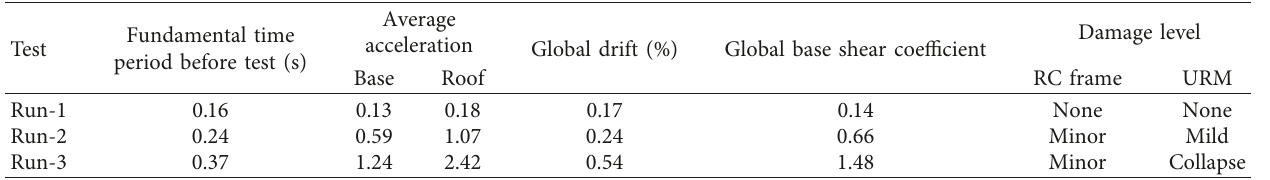
Table 7: Summary of structure response.